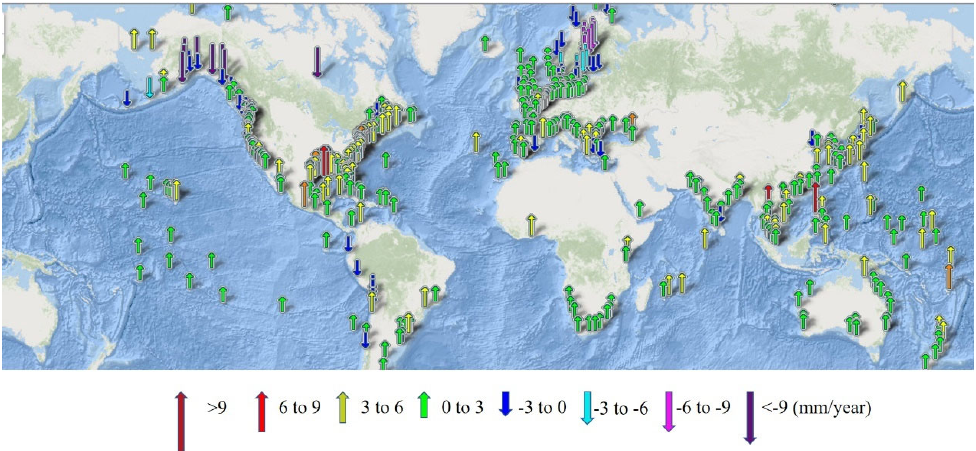
Figure 3. Global sea ‐ level rising trend.